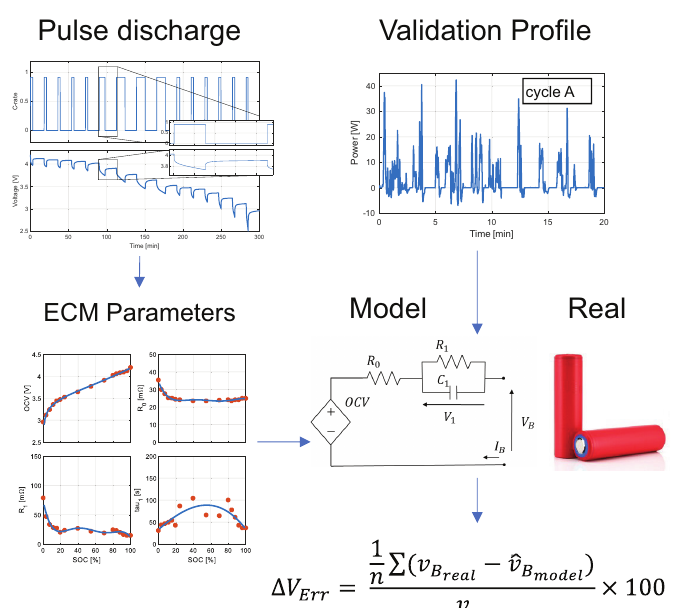
Figure 1. Model tuning and validation